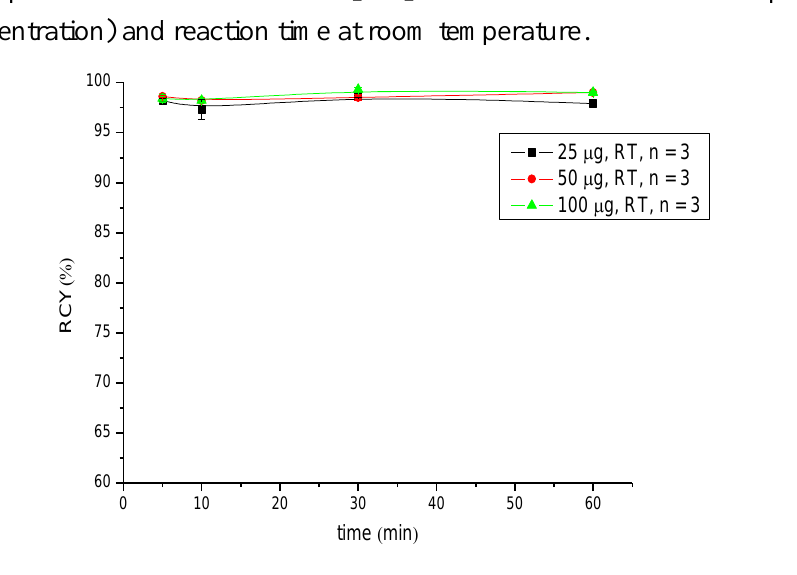
Figure 4. Dependence of the RCY of [ 177 Lu]Lu-CHX-A''-DTPA-DUPA-Pep on peptide amount (concentration) and reaction time at room